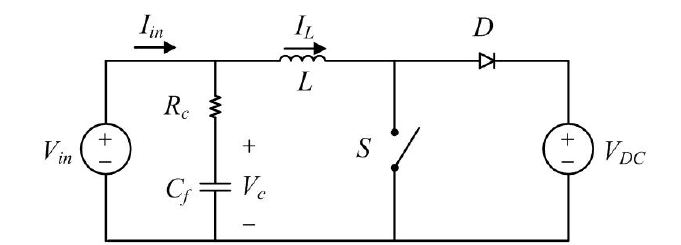
Figure 2. Equivalent circuit of the DC-DC